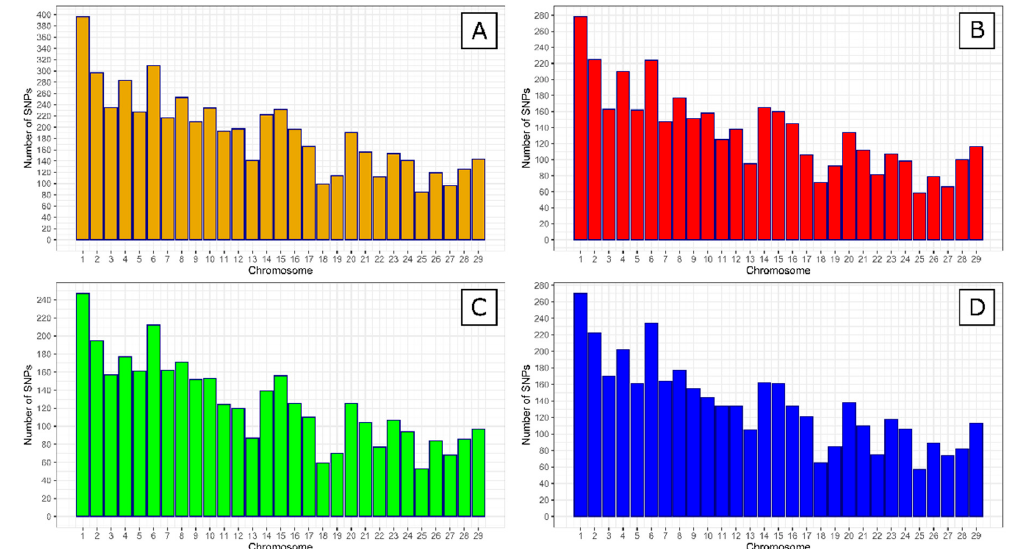
Figure 3. Number of polymorphic sites per chromosome in Caucasian tur ( Capra caucasica ) . A . Number of SNPs in all the studied populations. B . Number of SNPs in West ‐ Caucasian tur. C . Number of SNPs in East ‐ Caucasian tur. D . Number of SNPs in Mid ‐ Caucasian tur.